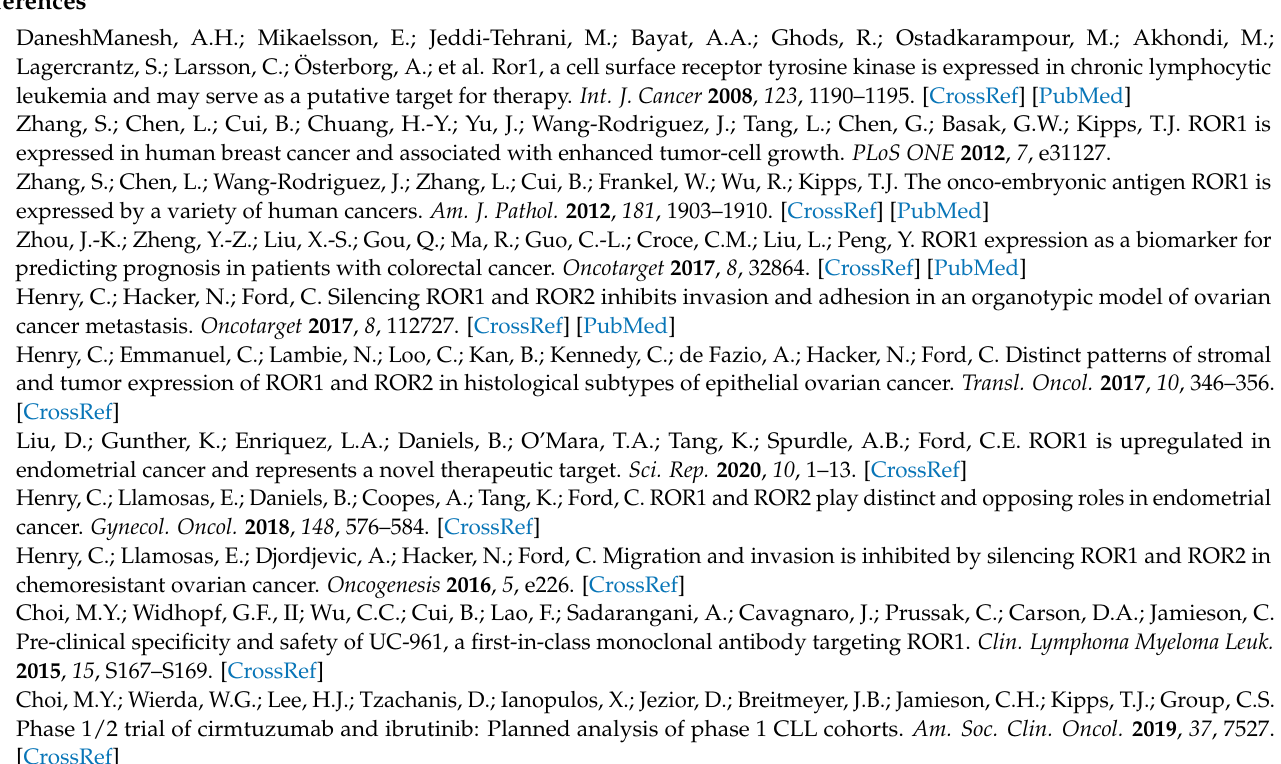
Figure S2. Cell confluence analysed via the IncuCyte S3 live imaging system over a period of 72 h. Table S1. Primer sequences used for qRT-PCR. Table S2. Cell confluence differences following different treatment conditions measured by the IncuCyte S3 platform in high-grade serous ovarian cancer and endometrial cancer cell